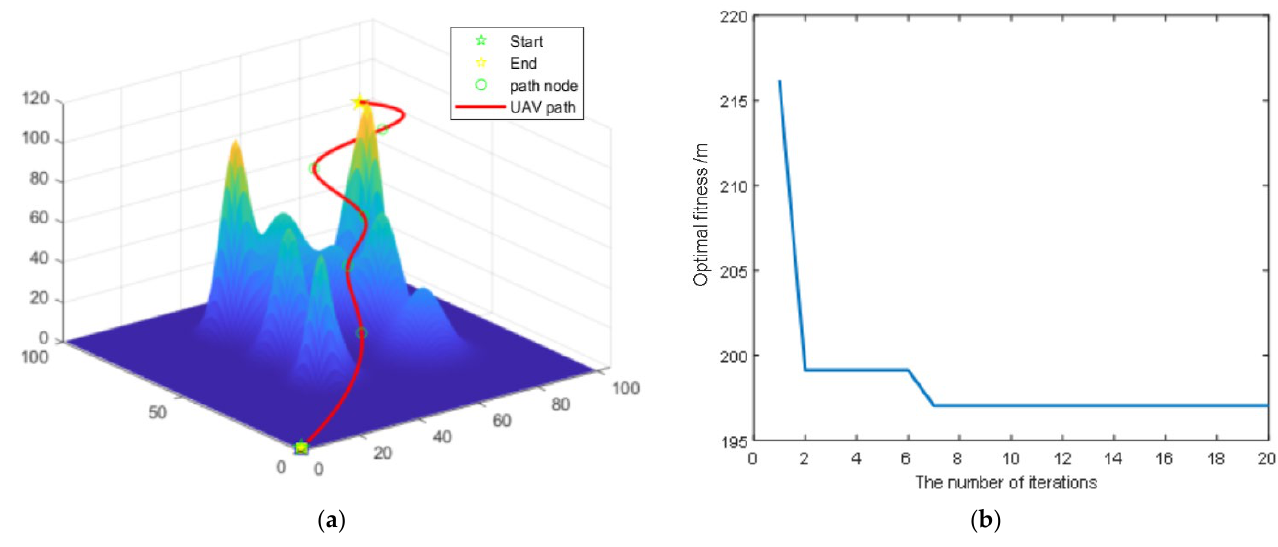
Figure 5. IGA algorithm: ( a ) path graph; ( b ) curve of iteration.